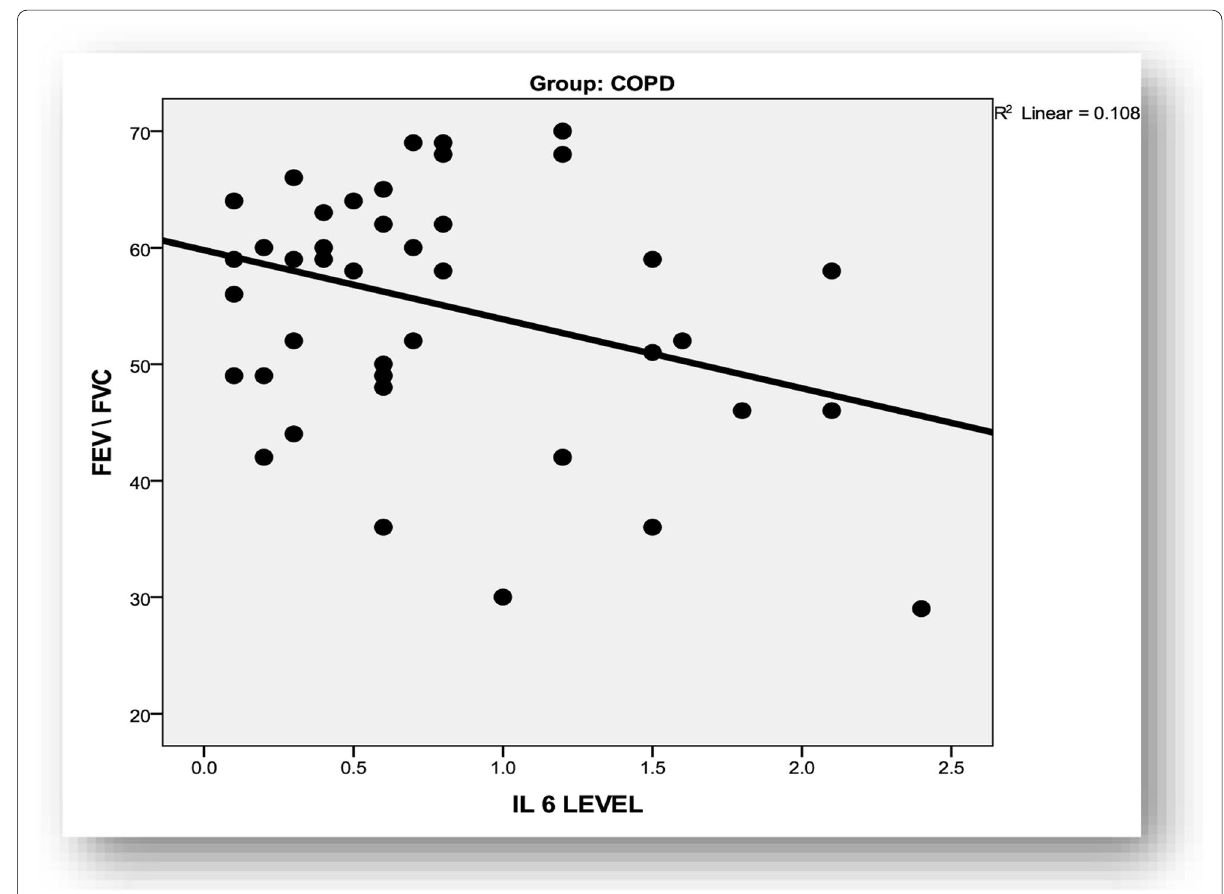
Fig. 2 Correlation between IL‑6 level with FEV/FVC among cases of